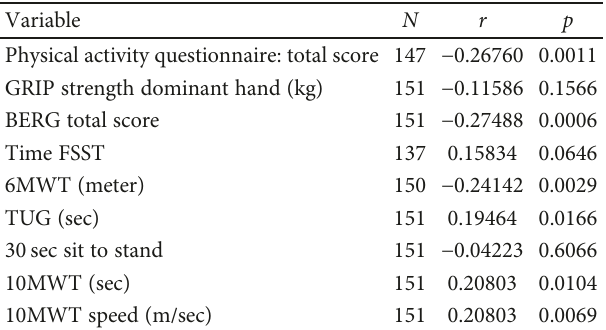
Table 2: Spearman correlation coe ffi cients between A1C and functional indices.